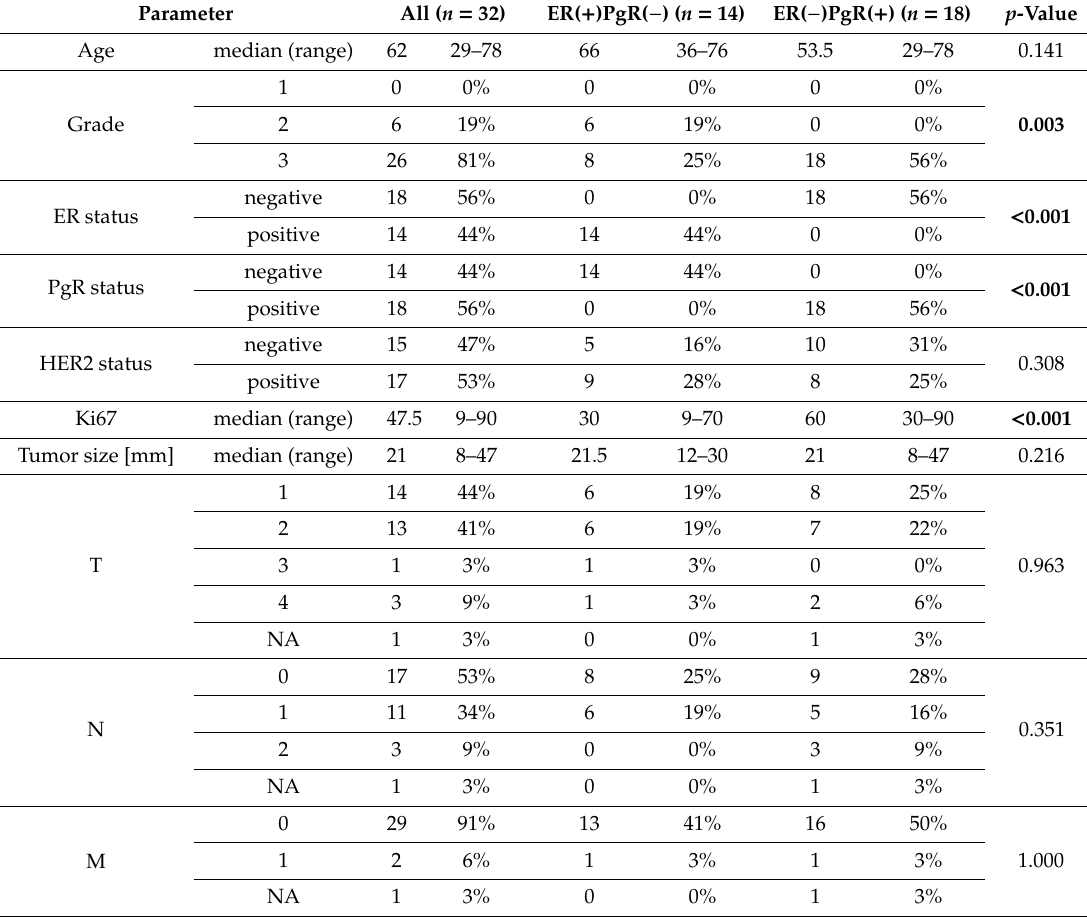
Table 1. Clinicopathological characteristics of patients with single hormone receptor-positive breast tumors in the NanoString cohort; di ff erences estimated with t -test (age, Ki67, tumor size) or Fisher’s Exact test (grade, estrogen receptor (ER) status, progesterone receptor (PgR) status, human epidermal growth factor receptor 2 (HER2) status, T, N, M); significant results ( p -value < 0.05) are in